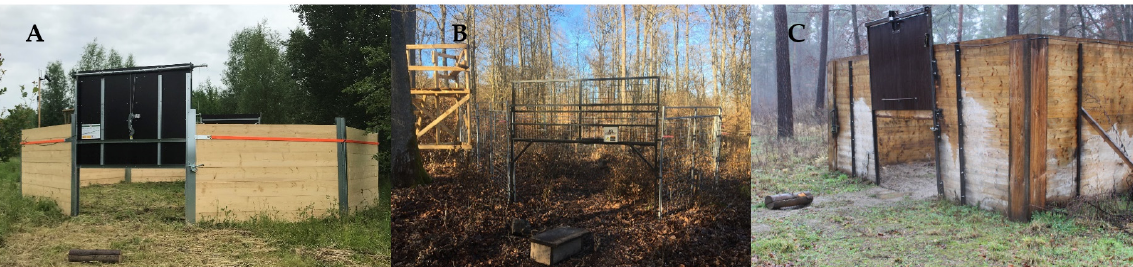
Figure 1. Pictures of the used corral-style traps. ( A ) Krefelder (Krefelder Saufang Vario, Thomas Vennekel & Georg Achten GBR, Krefeld, Germany); ( B ) JagerPro Trap System (Jager Pro ® , Inc. M.I.N.E. ® Trapping System, Columbus, GA, USA); ( C ) Selfmade trap type.